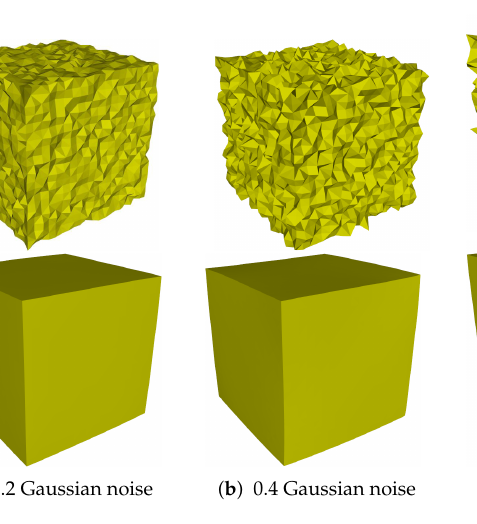
Figure 11. Denoising results of Cube